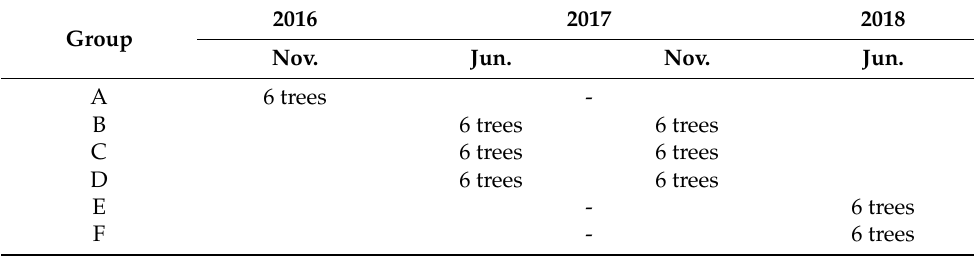
Table 2. The harvest sampling time and quantity of pear trees of each group. Group